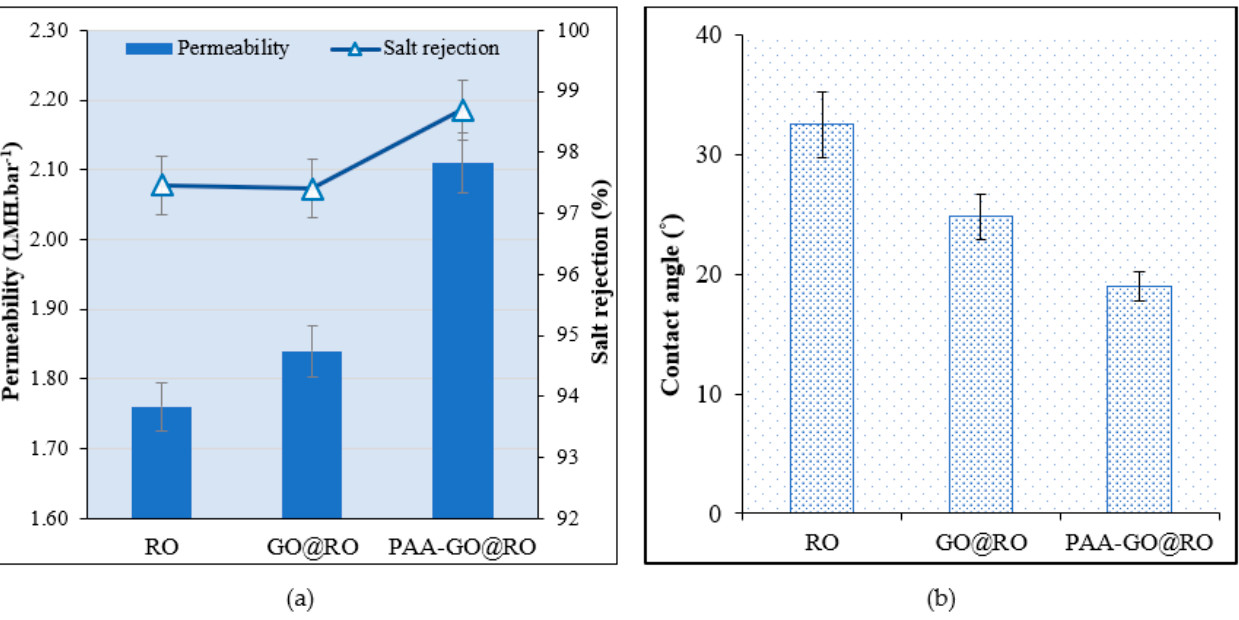
Figure 7. Results of ( a ) Membrane pure water permeability and salt rejection, ( b ) Water contact angle of the bared and optimized modified membrane.